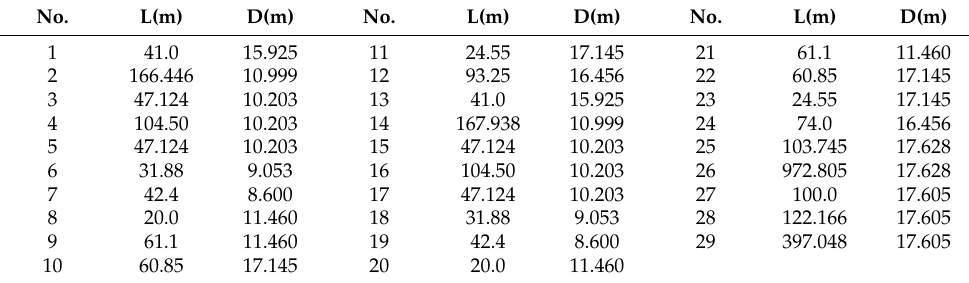
Figure 1. Sketch of the plan layout of the hydropower system. Table 1 lists the details of each pipe segment, including length and equivalent diameter, in the hydropower system. Table 1. Basic parameters of the pipe in the hydropower system.